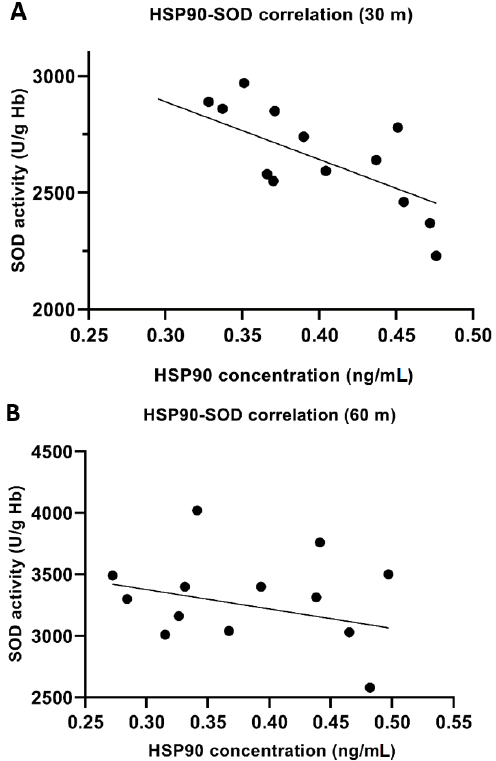
Figure 5 . Correlation between HSP90 concentration (before diving) and SOD activity (after diving) in erythrocytes—30 m exposition (r = − 0.58; p < 0.05) ( A ) and 60 m exposition (r = − 0.27; p > 0.05) ( B ).